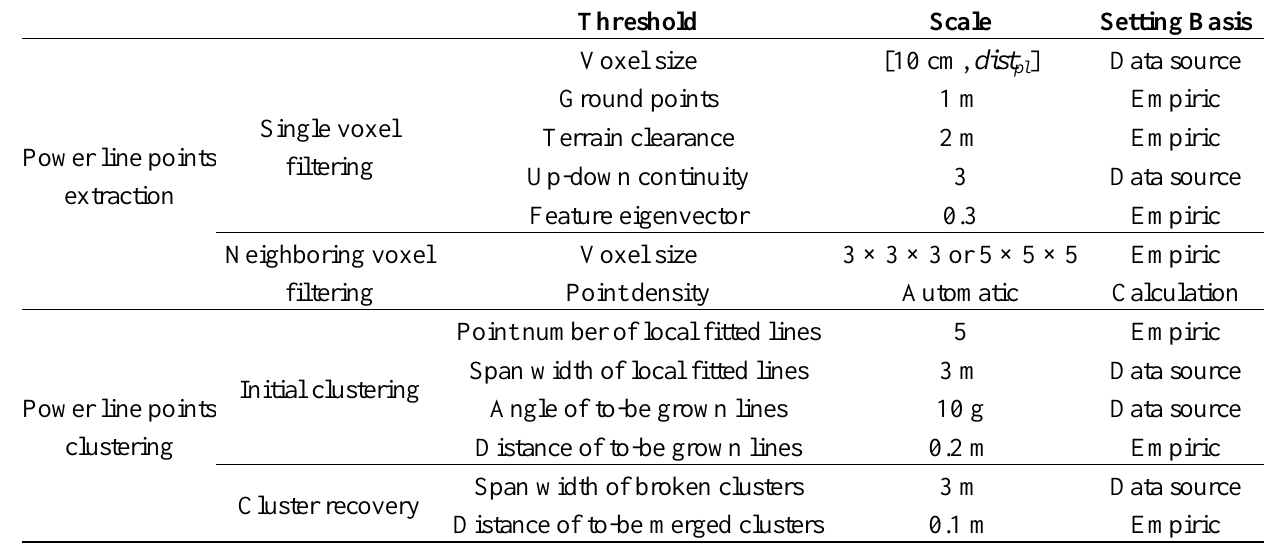
Table 1. Key parameters in the